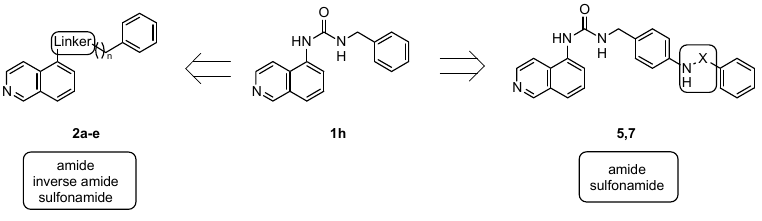
Figure 3. From isoquinolinyl urea 1h to novel derivatives 2a – e and 5 , 7 . Table 2. Isoquinoline amide and sulfonamide derivatives 2a – 2e .